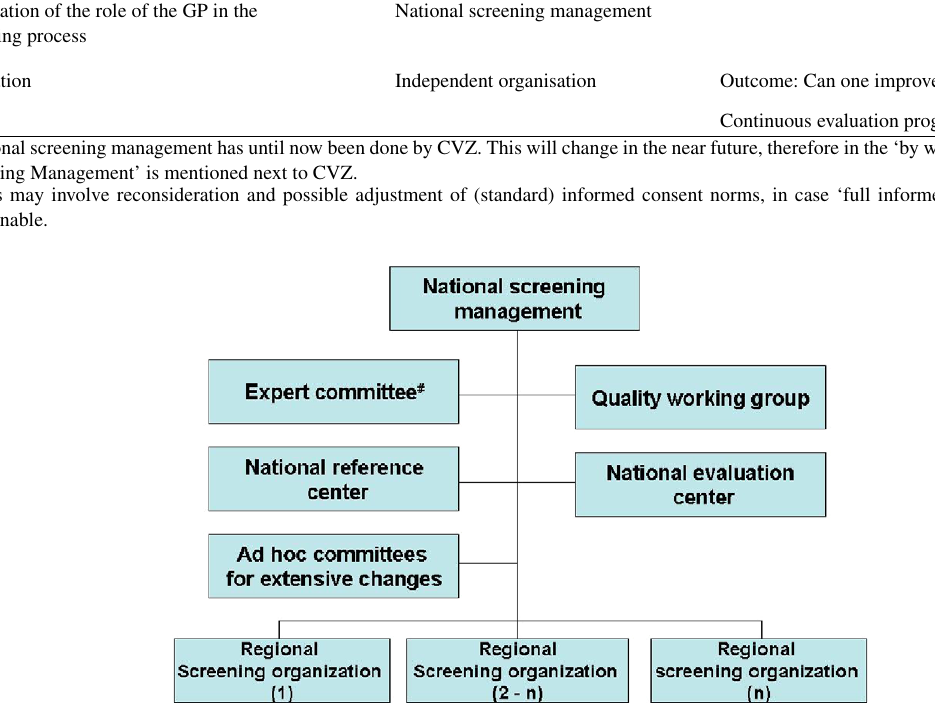
Fig. 3. Concept organogram of a national screening management. # It is proposed to form the expert committee as soon as possible to work on the organisational and research